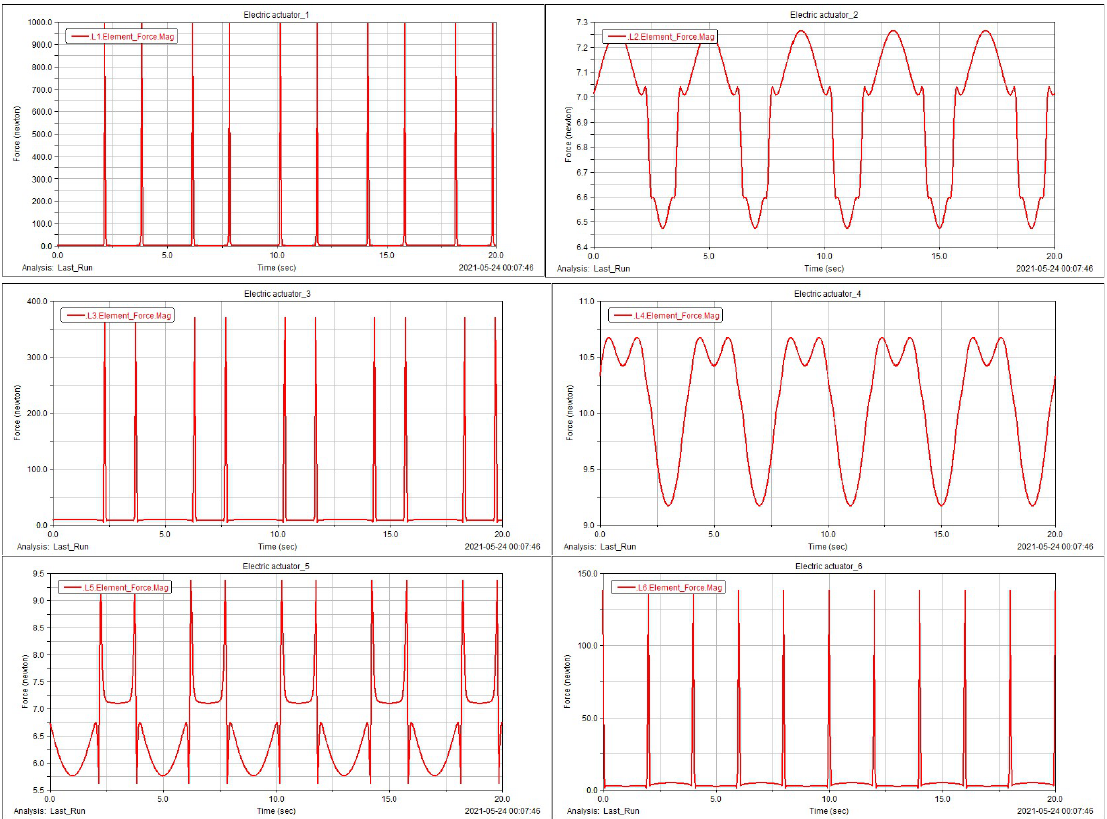
Figure 10. Force curve of electric cylinder.